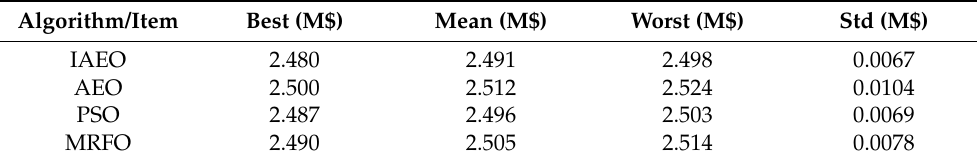
Table 4. Reliability and cost results of HPV/FC energy systems considering ENSP max = 1%.